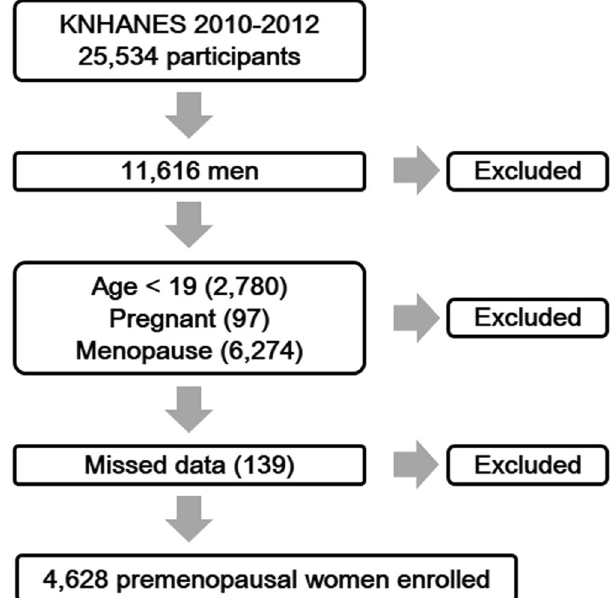
Figure 1. Flow chart of participant